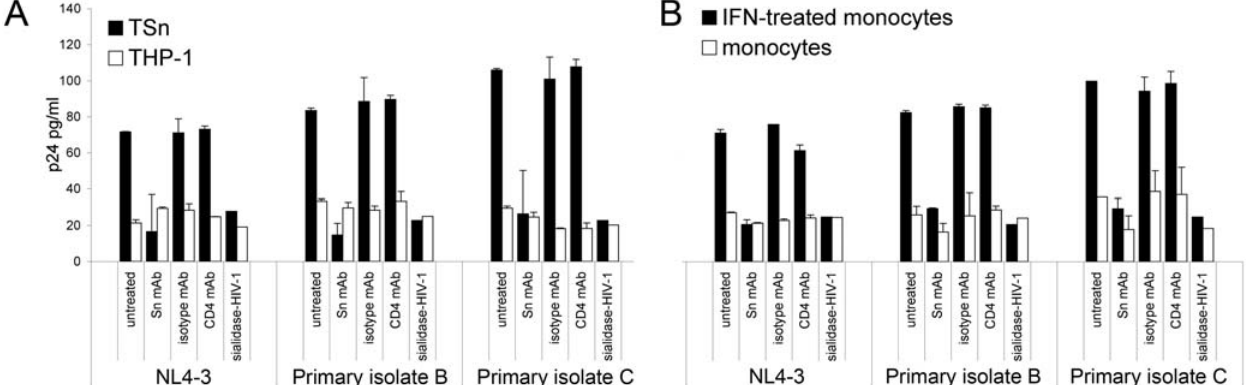
Figure 4. Sn binds HIV-1 invitro . (A) TSn binds HIV-1 in an Sn-dependant manner. TSn and THP-1 were incubated with lab-adapted HIV-1 NL4-3 , an HIV-1 clade B primary isolate or clade C primary isolate for 1 h at 37 u C, washed and then assayed for HIV-1 p24 by ELISA. HIV-1 binding to Sn was abrogated by pretreatment of cells with Sn mAb 7D2 or by pretreatment of HIV-1 with broad-spectrum sialidase. Pretreatment with IgG1 isotype control or CD4 mAbs did not reduce binding. Data presented are the average of 3 separate experiments. (B) IFN- a -treated CD14 + monocytes bind HIV-1 in an Sn-dependant manner. HIV-1 binding assays were also performed on CD14 + monocytes from seronegative controls treated with 500 U/ml IFN- a to induce Sn expression. Pretreatment with Sn mAb 7D2 and sialidase dramatically reduced HIV-1 binding while pretreatment with IgG1 isotype control or CD4 mAbs had little effect. Data represents monocytes from four separate donors. Error bars represent SD.